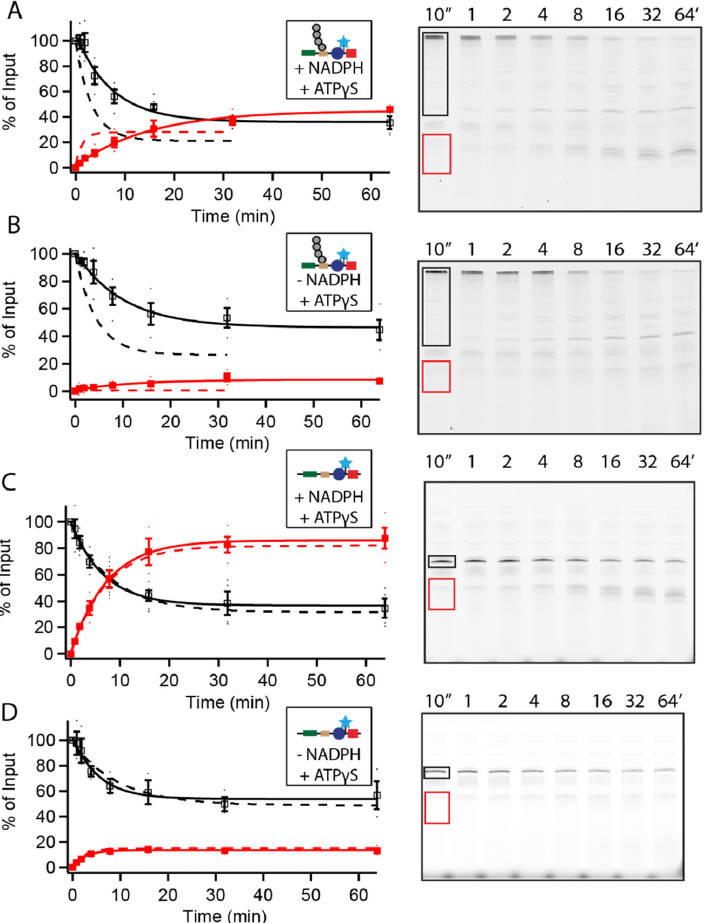
Figure 2. Degradation of UbID substrates is ATP-independent. ( A – D ) Degradation of 20 nM Rpn4 1 − 80 -PPXY-Barnase ∆ KL89G-C-DHFRk ∆ C by 100 nM WT proteasome in the presence of ATP- γ S. Example gels show full-length substrate, ( A , B ) ubiquitinated or ( C , D ) nonubiquitinated, outlined in black, and DHFR fragment outlined in red. Full-length (open squares) and DHFR fragment (closed squares) are shown as a percentage of total full-length present at the beginning of the reaction; full length is quantified as the sum of ubiquitinated and non-ubiquitinated substrate so any deubiquitination is not misinterpreted as degradation. Dots are the results from individual experiments and error bars represent the SEM of 3–4 experiments. Dashed lines are fits in the absence of ATP- γ S from Figure 1.